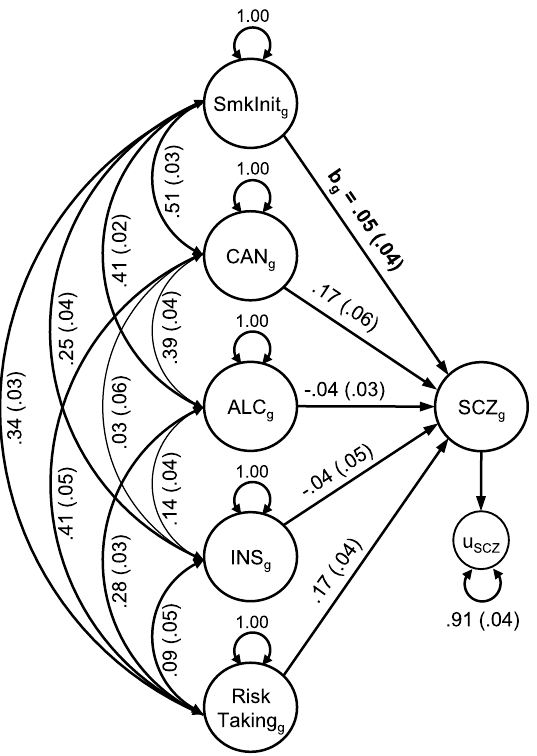
Figure 2. Path diagram illustrating genetic multiple regression models. SmkInit g = Genetic component of smoking initiation; CAN g = Genetic component of cannabis use; ALC g = Genetic component of alcohol consumption; INS g = Genetic component of insomnia; SCZ g = Genetic component of schizophrenia; u = residual genetic variance; b g = Conditional genetic correlation between the genetic components of smoking initiation and schizophrenia as summarized in Table 1; Double-headed arrow represents genetic covariance; Single-headed arrow represents regression paths; Path diagrams for models between all smoking behaviours and psychiatric phenotypes are provided in Supplementary Figures